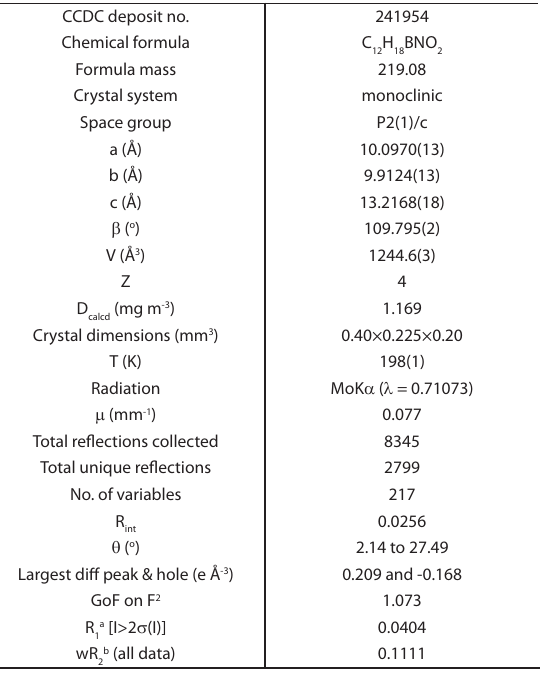
Table 1. Metal catalyzed borylation of 2-iodoaniline with pinacolborane.